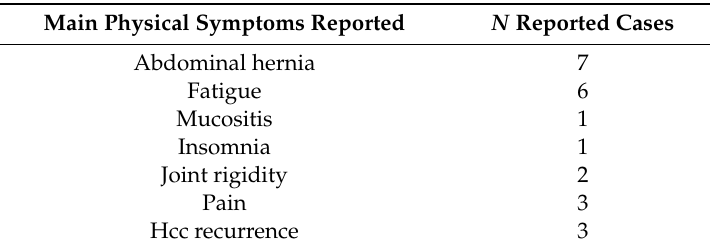
Table 3. Physical